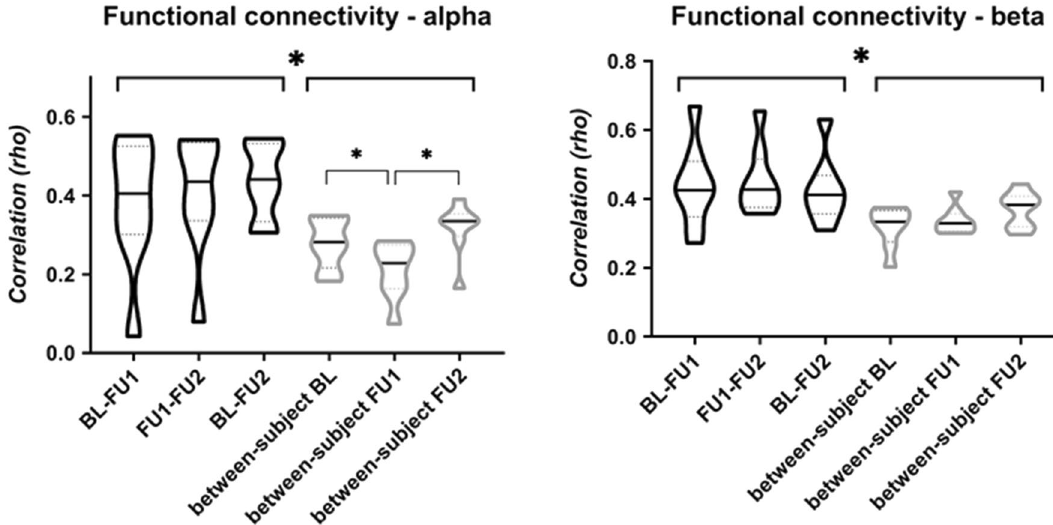
Figure 3. Functional connectivity analysis. Violin plots summarizing within and between-subject correlation values (Spearman’s rho) between functional connectivity matrices at different time points. Connectivity matrices consisted of alpha (8–13) and beta (13–30) band amplitude envelope correlation (AEC) values, corrected for signal leakage. No significant differences were found between average within-subject values using repeated measures ANOVAs, but between-subject alpha band functional connectivity values differed between time points BL–FU1 and FU1–FU2 (Table 1). Note that on average, the within-subject correlations were significantly higher than the between-subject correlations (alpha band t(46) = 4.27, p = 0.011; beta band t(46) = 4.12, p < 0.001); average values also provided in Table 1). * p <